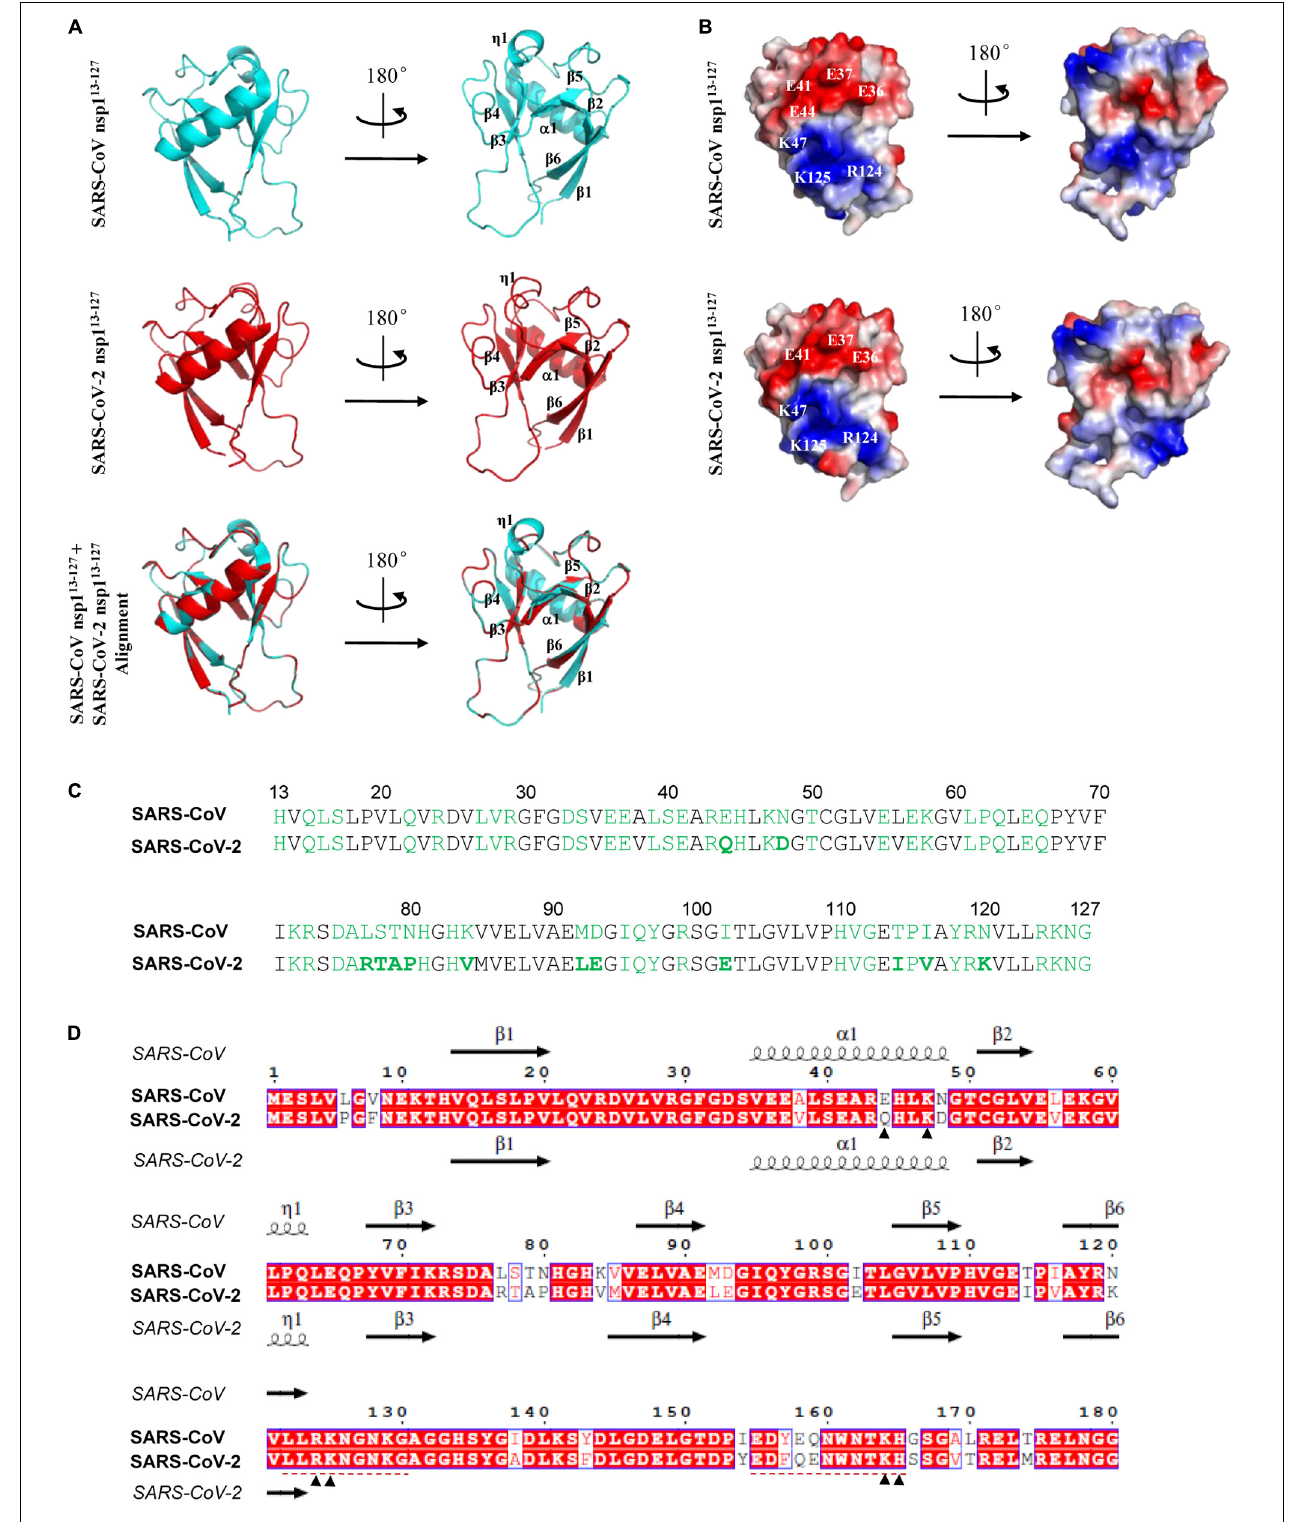
FIGURE 4 | Predicted structure features of SARS-CoV-2 nsp1. (A) Ribbon models of the SARS-CoV and SARS-CoV-2 nsp1 structures. The determined NMR structure of SARS-CoV nsp1 13 - 127 (residues 13–127) was downloaded from Protein Data Bank (PDB code: 2HSX) as shown in cycan. The structural modeling of SARS-CoV-2 nsp1 13 - 127 was conducted by target-template alignment using SWISS-MODEL server with the structure of SARS-CoV nsp1 13 - 127 as template.